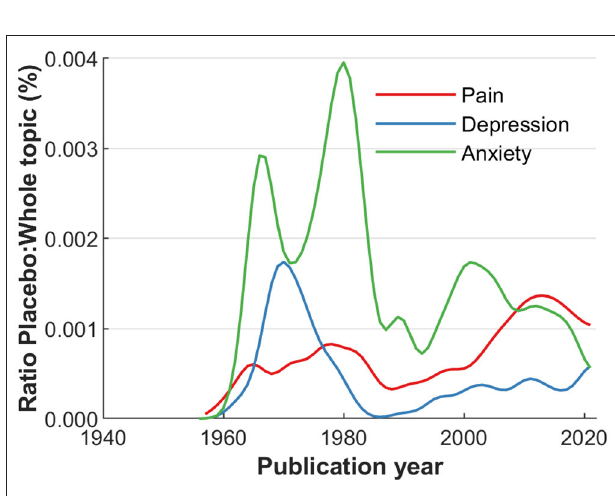
FIGURE 6 | Major MeSH term occurrence in the database, compared to the number of citations in the entire respective PubMed field (pain, depression, anxiety) over time. Absolute percentages are low, but allow to identify peaks of interest and trends in the respective fields. Data is smoothed over 5